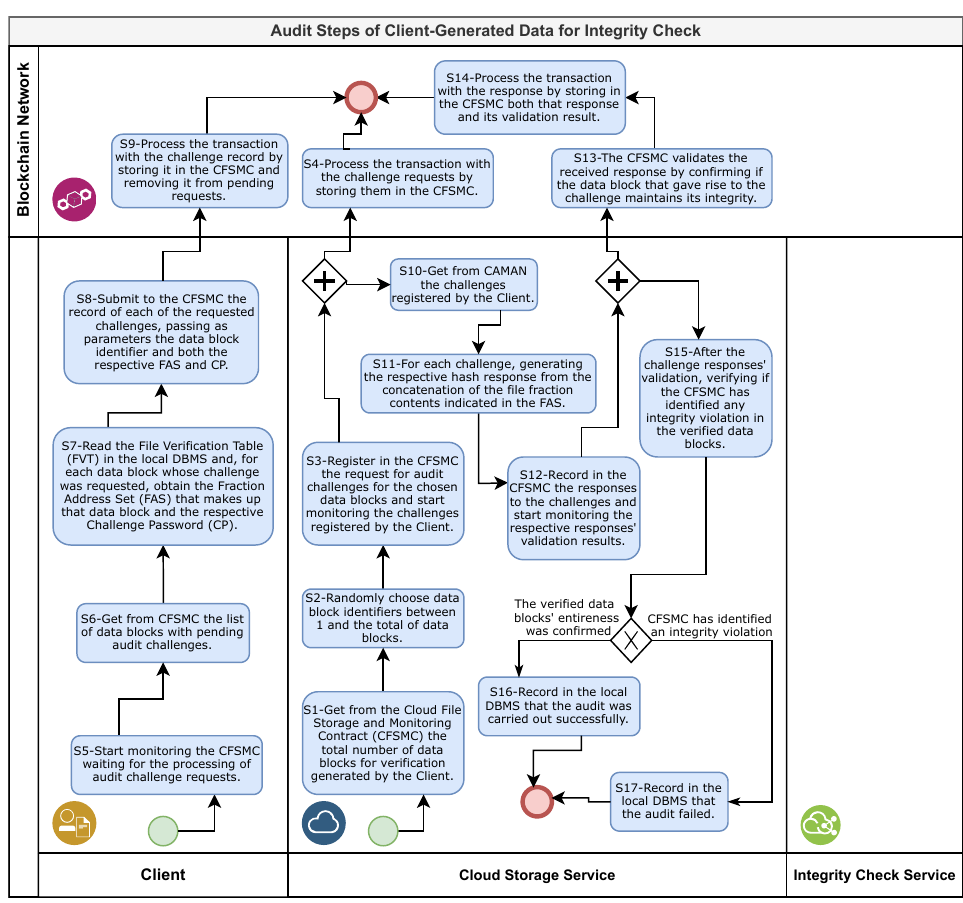
Figure 6. Audit steps of the data for integrity